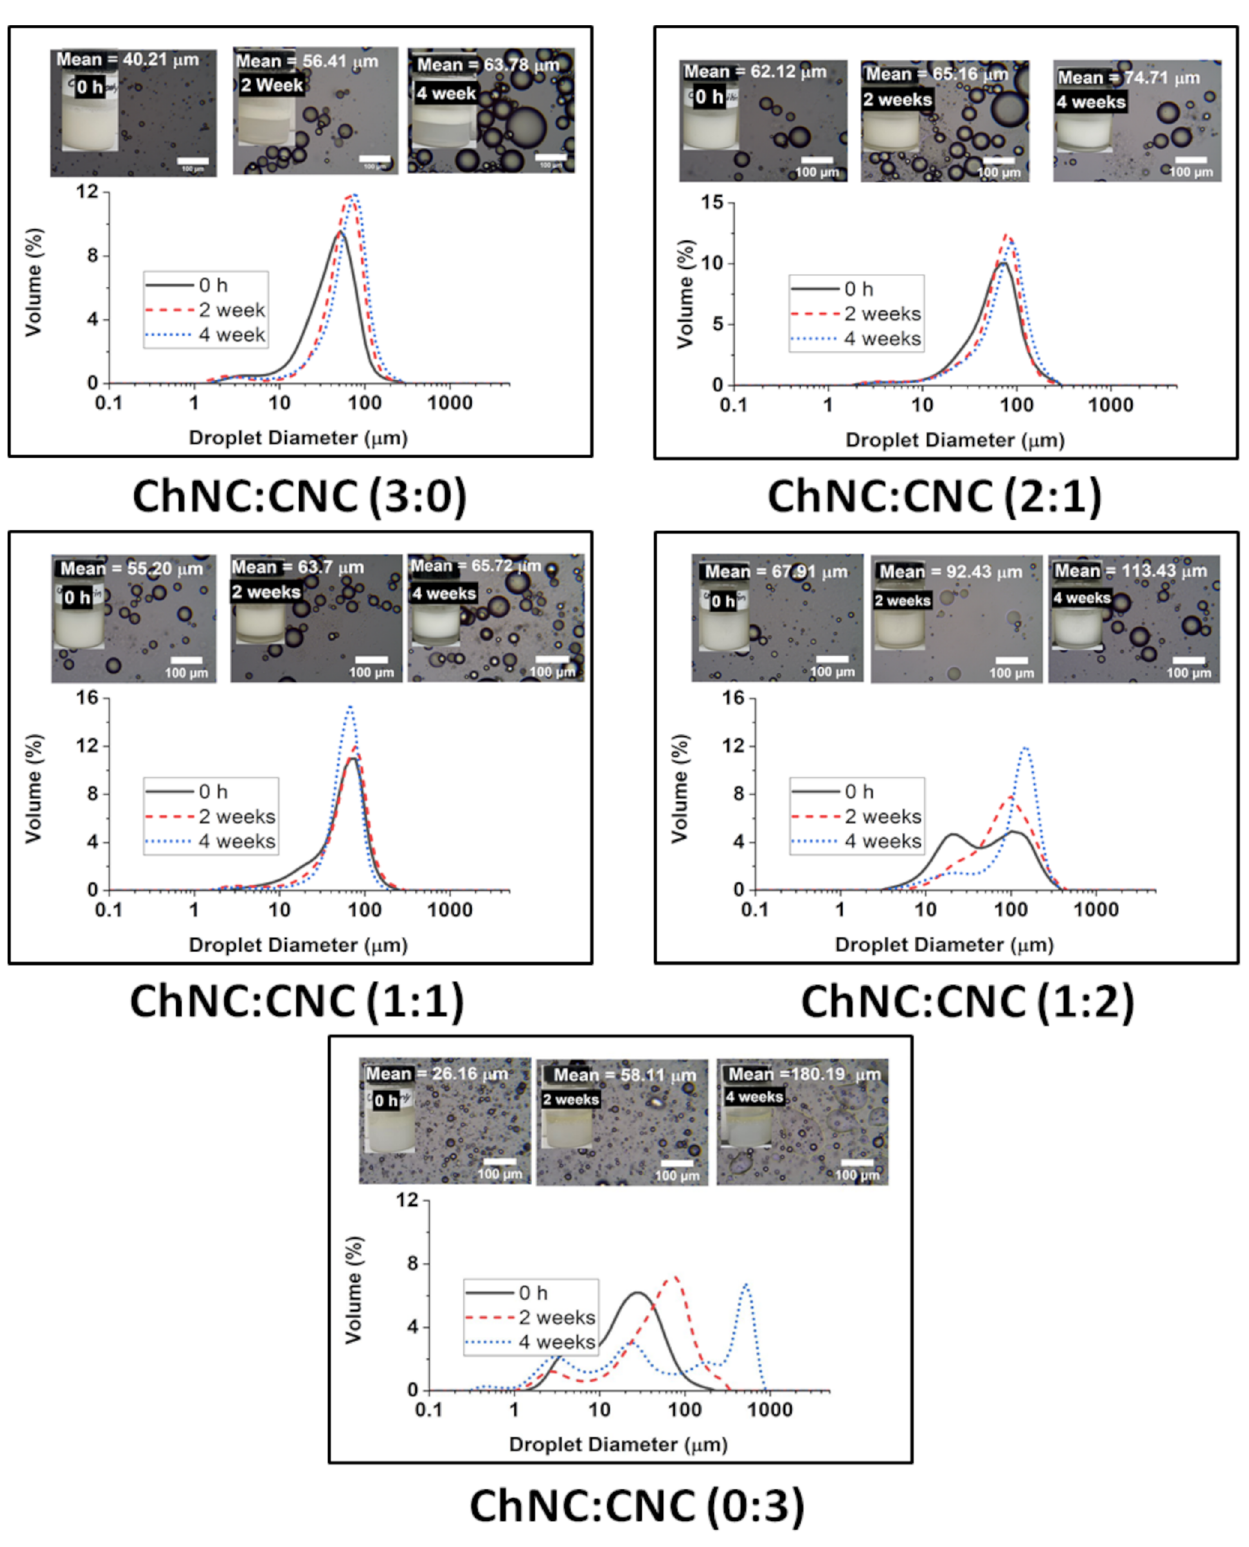
Figure 7. Droplet size distribution of soybean oil emulsions prepared using different ChNC:CNC mass ratios over a period of 4 weeks. The insets show optical microscopy images of each sample and pictures of the emulsions inside vials. The experiments were performed at just 20 mM NaCl, and a total NP concentration of 0.8 wt%.